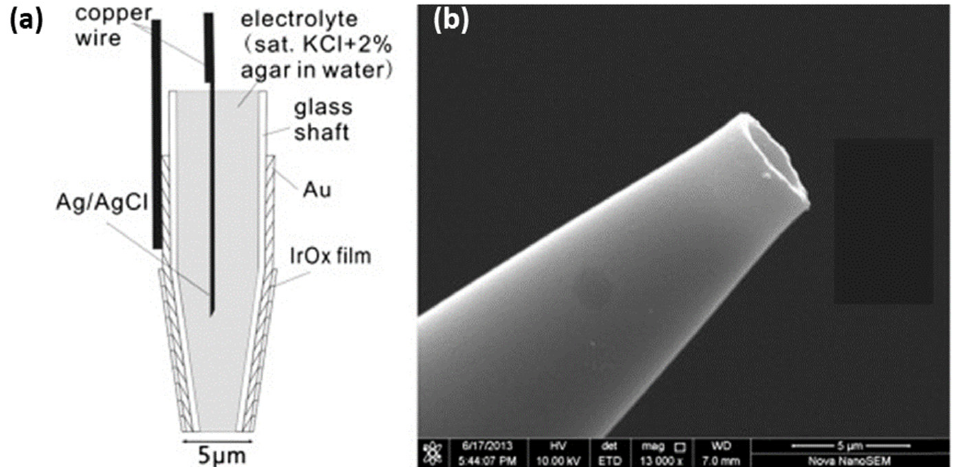
Figure 3. ( a ) Schematic of the coaxial pH sensor. ( b ) SEM micrograph of the ~5 µ m tip of the pH sensor without the reference electrode. Reprinted from ref. [49]. Copyright (2014) with permission from Elsevier.